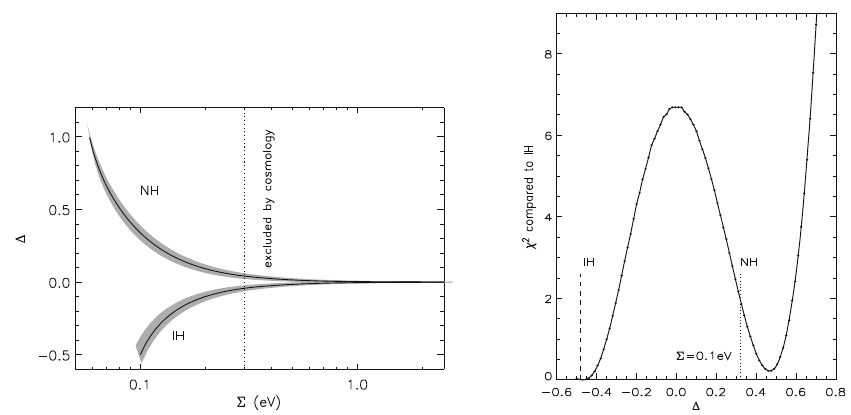
Fig. 42 Left: region in the Δ – Σ parameter space allowed by oscillations data. Right: Weak lensing fore- casts. The dashed and dotted vertical lines correspond to the central value for Δ given by oscillations data. In this case Euclid could discriminate NI from IH with a Δχ 2 = 2. Image reproduced by permission from Jiménez et al. (2010); copyright by IOP and